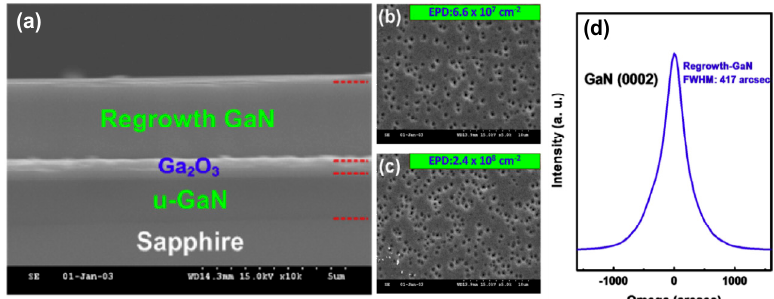
Figure 11. ( a ) Cross-sectional SEM image of the sample and ( b ) the etch-pit distribution observed by SEM image for the regrowth GaN epilayer grown on Ga 2 O 3 / Eco-GaN template. ( c ) The etch-pit distribution observed by SEM image for the u-GaN grown on sapphire. ( d ) XRD rocking curve of (0 0 0 2) reflection. Reprinted with permission from Reference [120]. Copyright 2015 Elsevier.